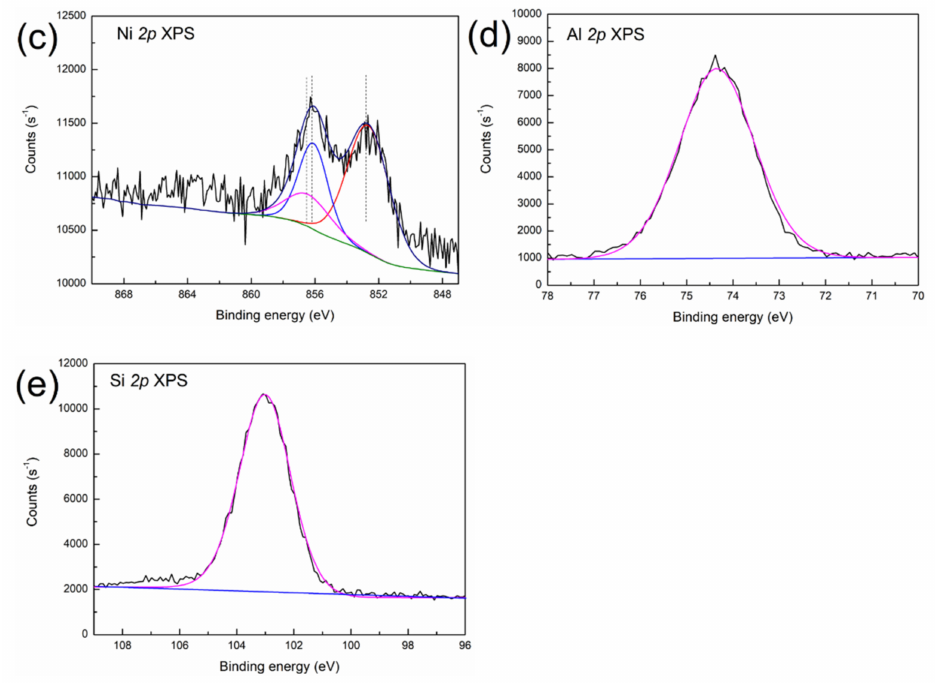
Figure 3. XPS spectra of ( a ) V 2p , ( b ) Fe 2p , ( c ) Ni 2p , ( d ) Al 2p and ( e ) Si 2p in the SFCC catalyst.